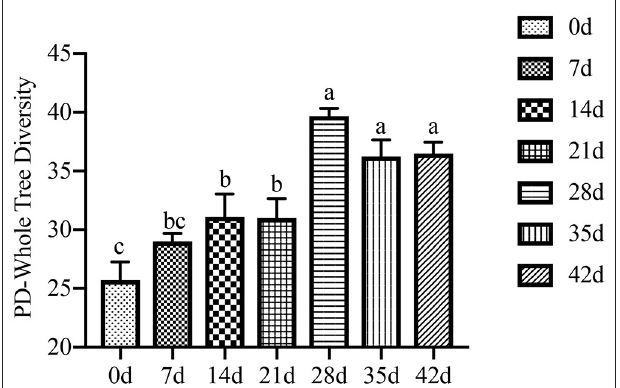
FIGURE 4 | Effect of piglet age on colonic chyme α -diversity (phylogenetic distance, PD). Values are means with standard errors represented by vertical bars. a, b, c Mean values with unlike letters were significantly different within a cluster of bars, not across the clusters of bars ( P <